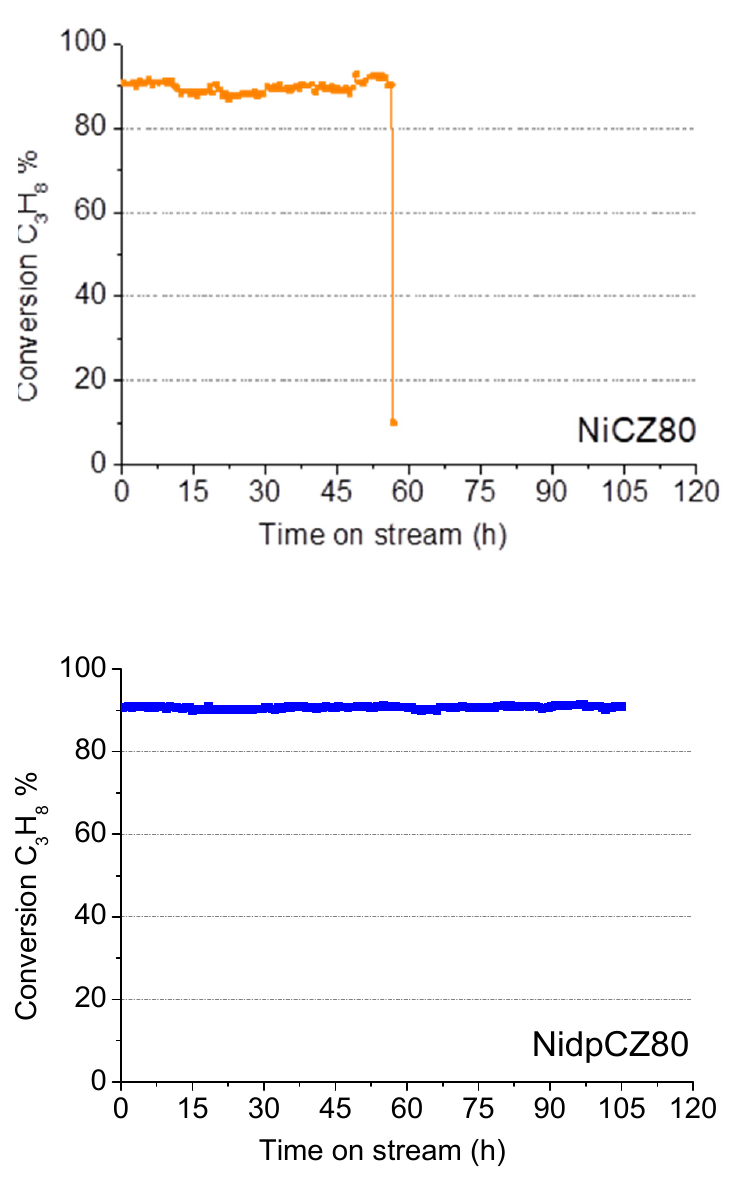
Figure 12. Profiles of C 3 H 8 conversion for NiCZ80 and NidpCZ80 under ATR conditions at T = 800 °C and GSHV = 120,000 h − 1 .